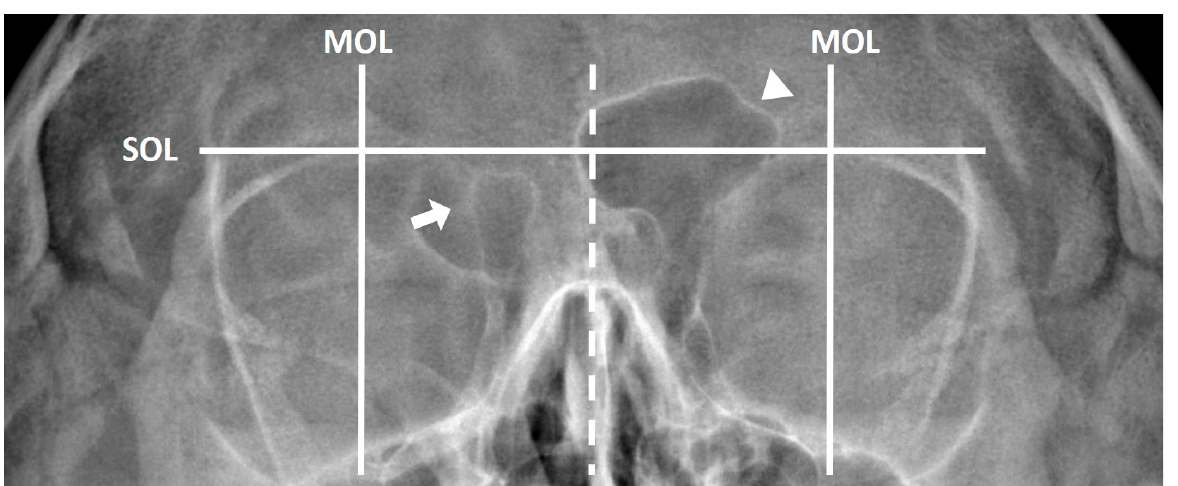
the bilateral medial orbital walls (Figure 2).